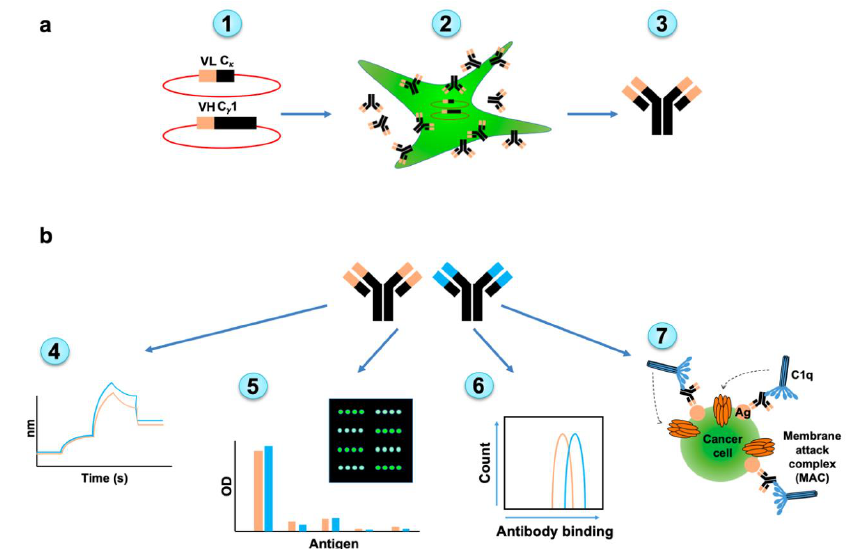
Figure 3. Overview of full-antibody expression and subsequent characterization. ( a ) Full length human IgG antibodies were generated from native and selected-mutants scFv clones. Variable heavy chain (VH) and variable light chain (VL) sequences were cloned into hIgG1/kappa vectors (1). The 293A cells were transfected to produce the full length antibodies (2). Antibodies were purified from cell media (3). ( b ) Full length antibodies were characterized for their affinity by bio-layer interferometry (BLI) (4), specificity by ELISA, and glycan microarray (5), cancer cell binding (6), and complement-dependent cellular cytotoxicity (7).